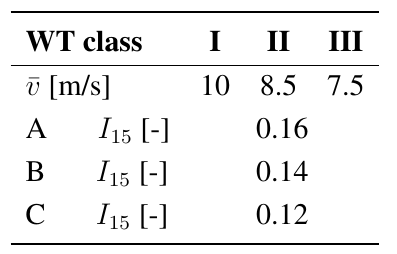
Table 1. Wind turbine classes according to IEC 61400-1